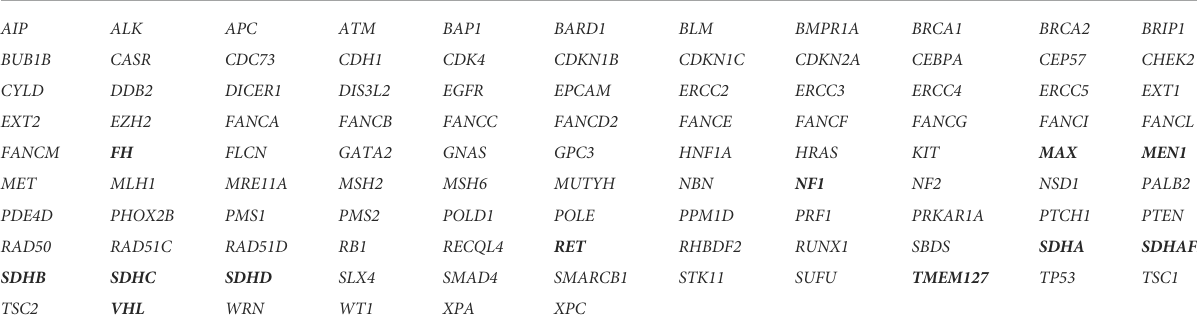
TABLE 1 Genes included in the multigene